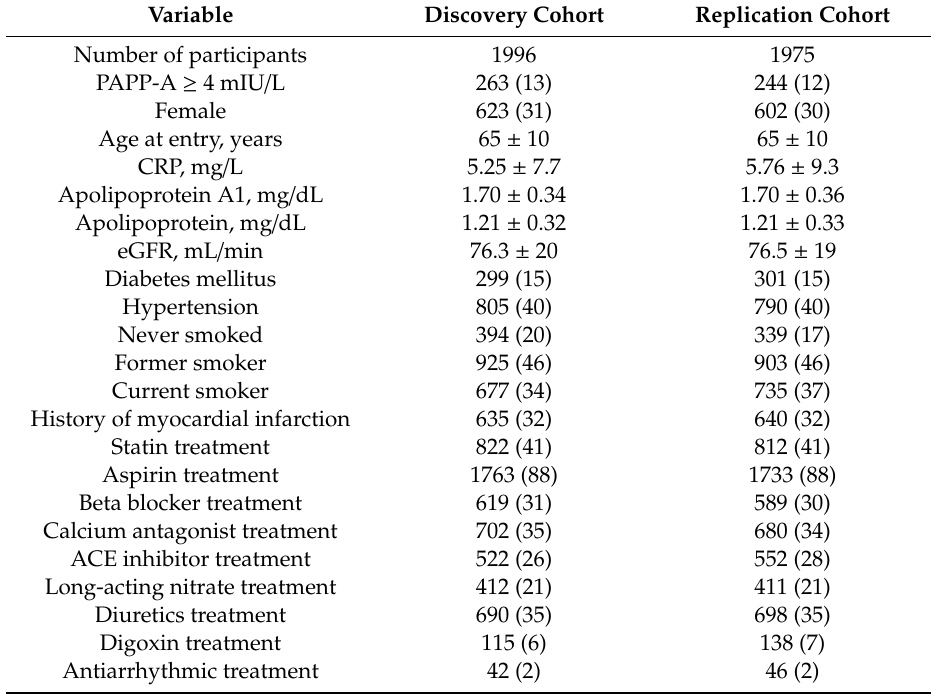
Table 1. Baseline characteristics of the two study cohorts.